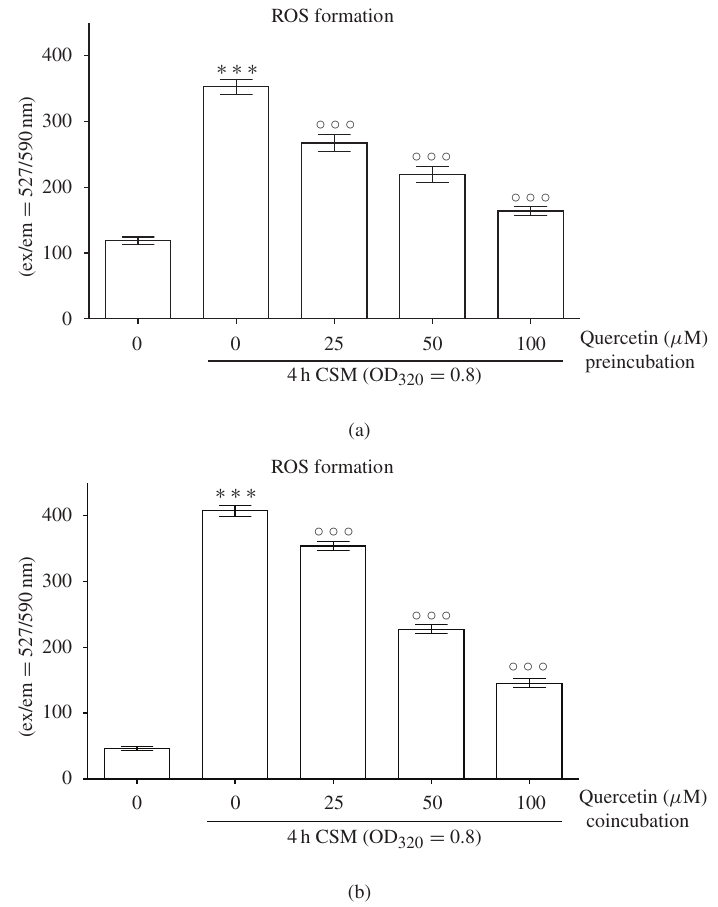
FIGURE 2: Quercetin reduces CSM-induced ROS production in primary human osteoblasts. (a) Pre- incubation of primary human osteoblasts ( N = 3 , n = 4 ) with subtoxic concentrations of Quercetin (25, 50, 100 μ M) reduces the formation of ROS after 15 min treatment with CSM (OD 320 = 0.8). (b) Similar results were observed during coincubation. ∗∗∗ P < 0 . 001 compared to untreated cells, ◦◦◦ P < 0 . 001 compared to CSM-treated